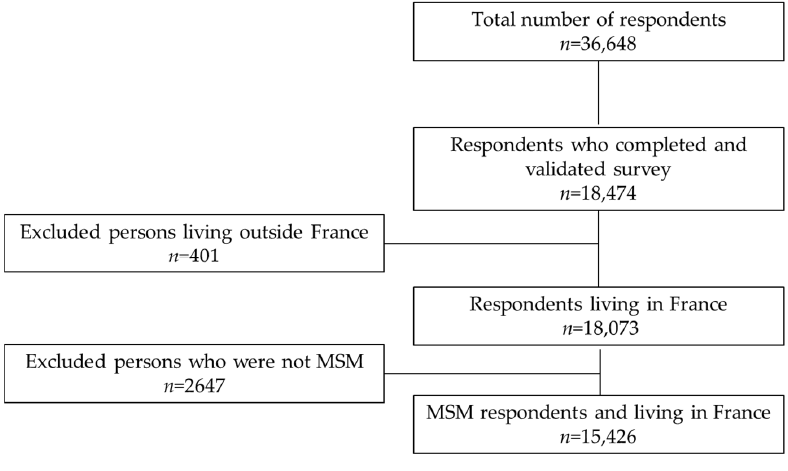
Figure 1. Participant flow chart. Most of the respondents were born in France (94.6%), lived in an urban area (82.8%), and had a third-level education level (68.2%). Just under a third (31.1%) had a low level of health literacy, and 14% perceived their financial situation as difficult. With regard to COVID-19, 42.5% of respondents reported having COVID-19-like symptoms or signs, and 9.7% had been diagnosed with the disease. At the time of the study (February to April 2021), 60.5% of respondents were already COVID-19 vaccinated or intended to vaccinate, 17.5% did not intend to vaccinate, and 22% were uncertain about vaccinating (Table 1). Table 1. Participants’ characteristics ( n = 15,426).